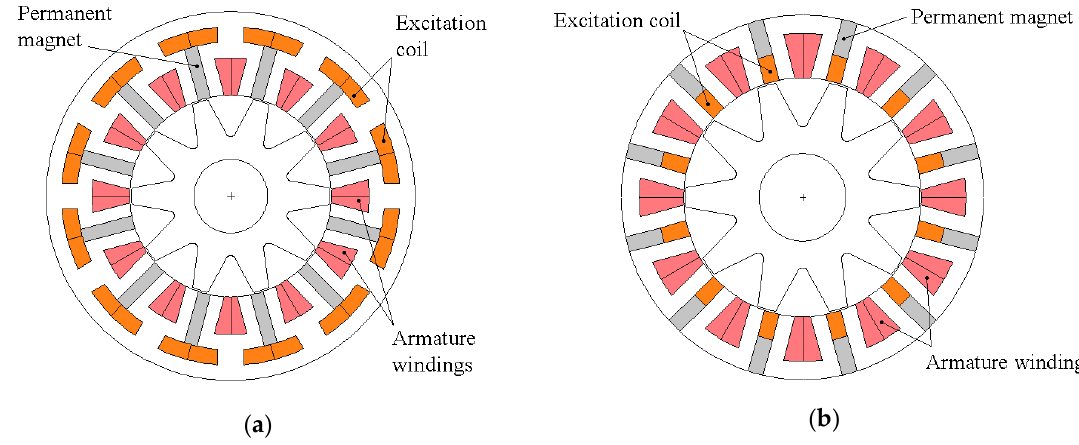
Figure 1. Hybrid excited flux-switching structures. ( a ) With iron flux bridges [31,41,42]; ( b ) without iron flux bridges [44].